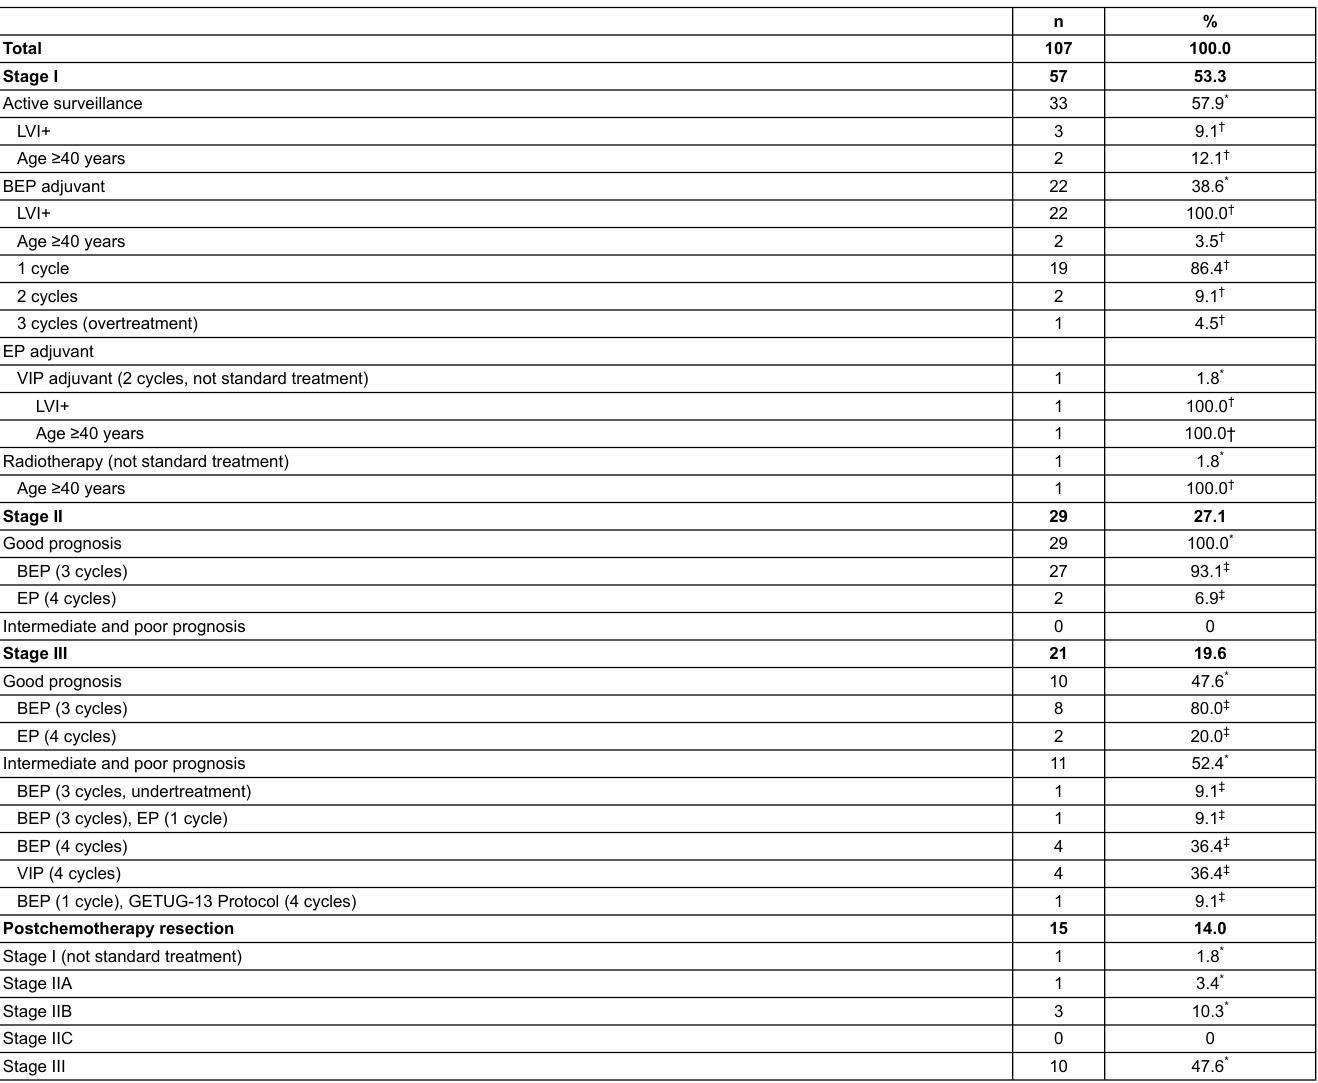
Table 5: Summary of treatment in non-seminoma